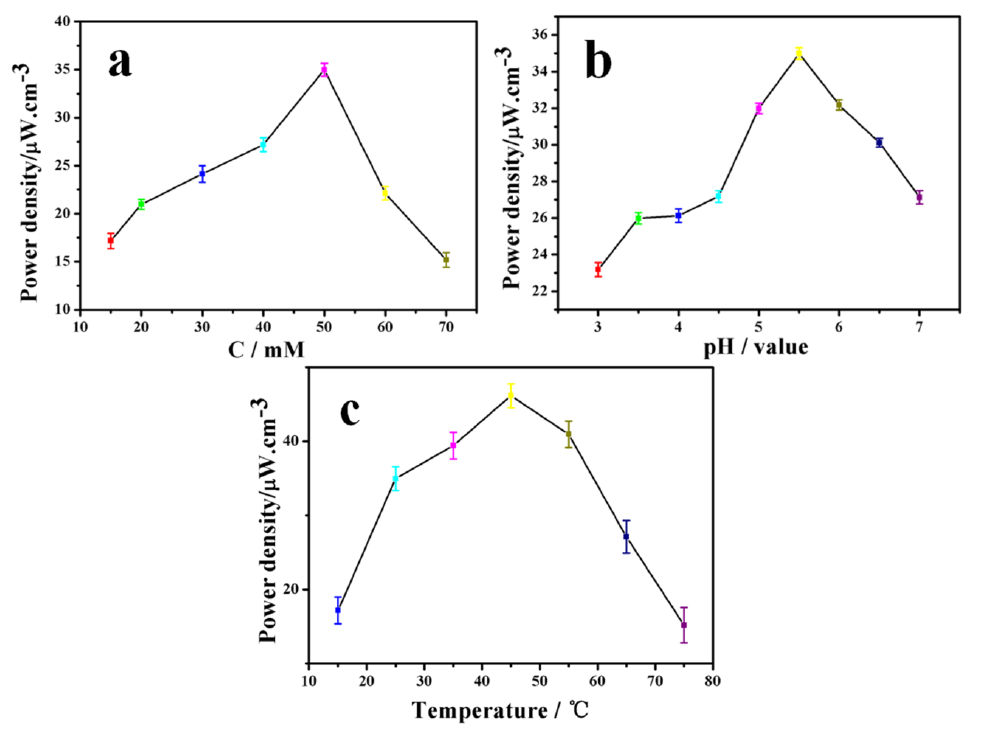
Figure 7. The maximum power output of the EBFC with different conditions: ( a ) glucose concentrations; ( b ) optimum pH; and ( c ) optimum temperature.